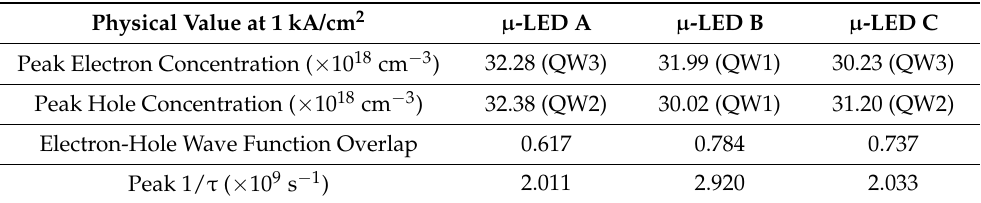
larger 1/ τ . Compared with µ -LED B, the electron-hole wave function overlap of µ -LED C hole concentration is slightly higher. Importantly, the peaks of the carrier concentration of µ -LED B are concentrated in the same QW, making the peak of 1/ τ greatly increased. Table 1. Peak electron concentration, peak hole concentration, electron-hole wave function overlap, and peak 1/ τ for µ -LED A, µ -LED B, and µ -LED C at 1 kA/cm 2 . Physical Value at 1 kA/cm 2 µ -LED A µ -LED B µ -LED C Peak Electron Concentration ( × 10 18 cm − 3 ) 32.28 (QW3) Electron-Hole Wave Function